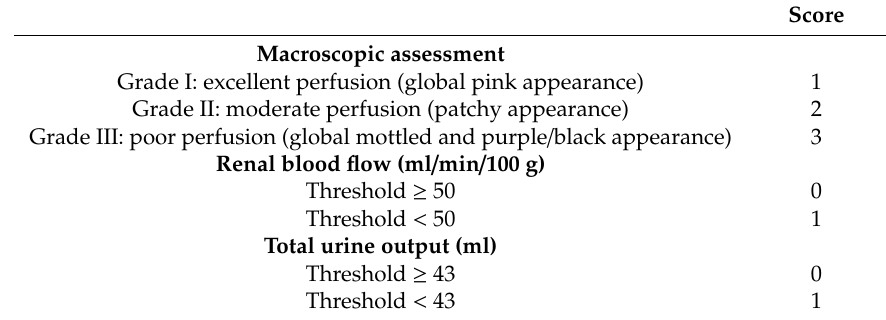
Table 1. Kidney quality assessment score for kidneys undergoing 1 hour of preimplantation normothermic perfusion